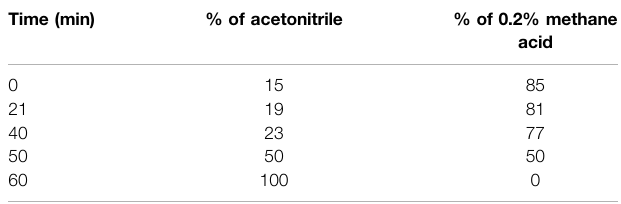
TABLE 1 | HPLC elution pro fi le for TFENF( fl ow rate: 1 ml/min). Time (min) % of acetonitrile % of 0.2% methane